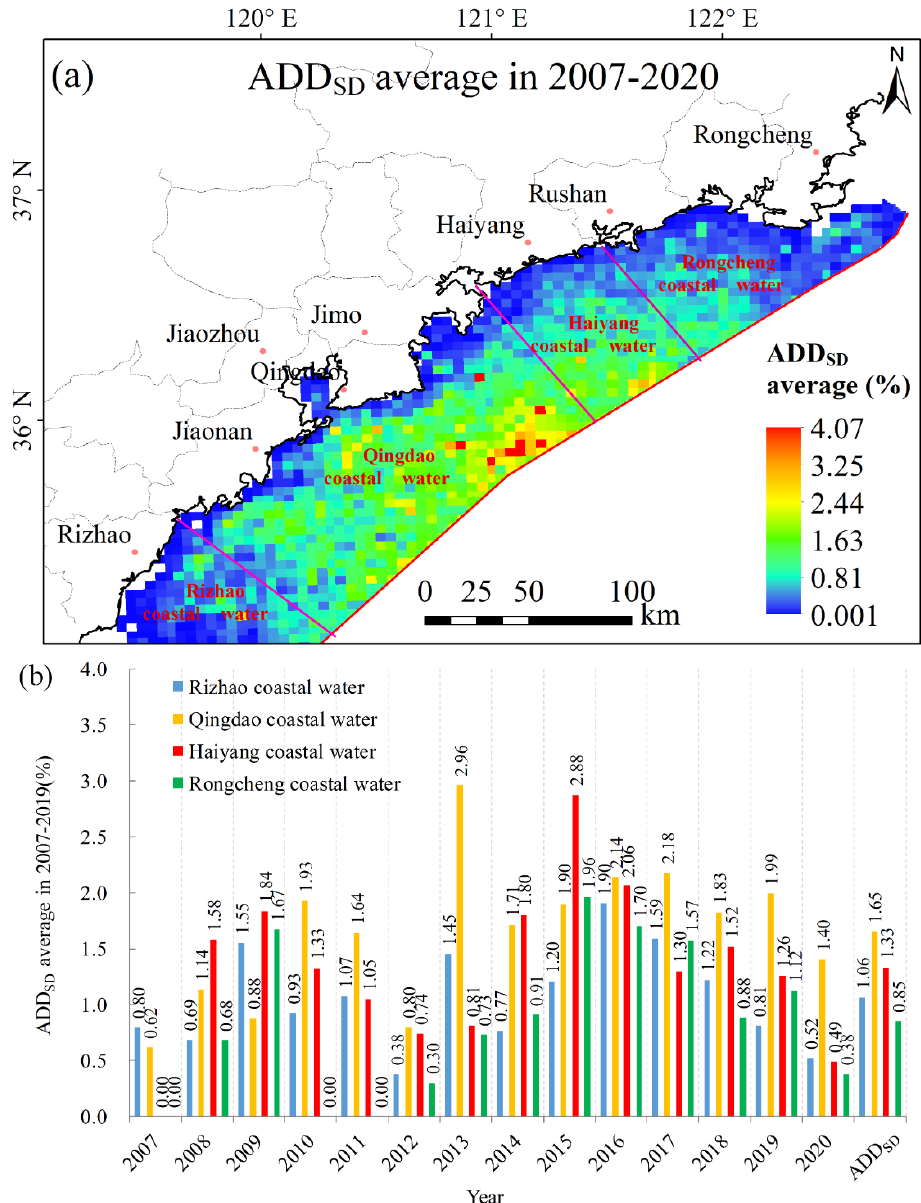
Figure 11. The ADD variation of MABs on the southern Shandong Peninsula coastal water ( ADD SD ): ( a ) ADD SD average in 2007–2020; ( b ) Interannual variation of ADD SD on four regions from 2007 to 2020. These four regions were the coastal water of Rizhao, Qingdao, Haiyang and Rongcheng, respectively. ADD is the annual distribution density of MABs, and the southern Shandong Peninsula coastal water was determined according to the Marine Function Zone in Shandong Province in this study.